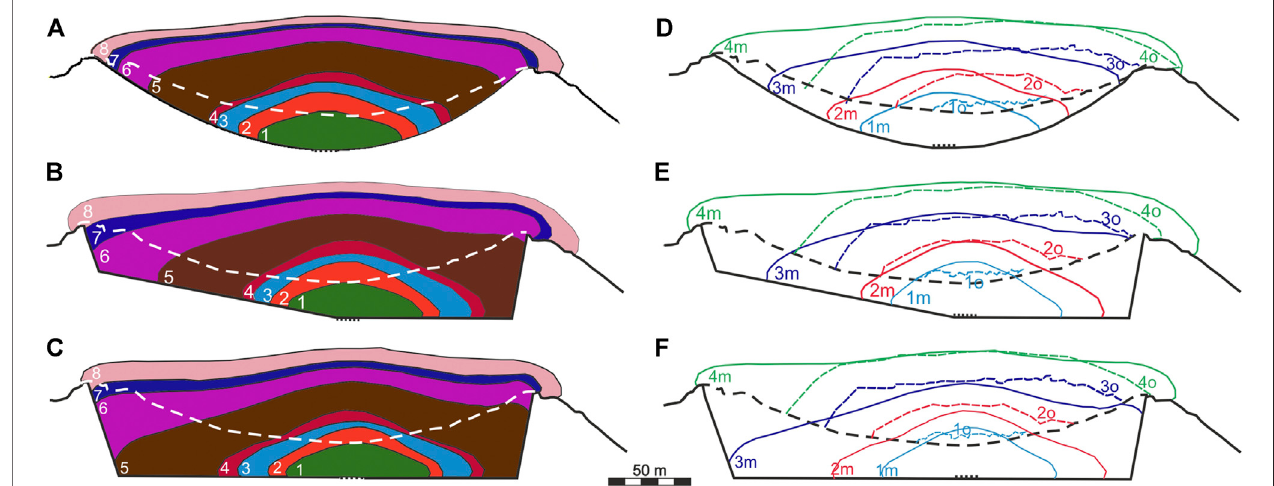
FIGURE6| Lavadomegrowth inexperiment4 (Aand D) ,5 (BandE) ,and6 (CandF) . (A – C) Thedomemorphologyatday150(the curvemarkedby1),300(2), 434 (3), 480 (4), 700 (5), 852 (6), 912 (7), and 1,020 (8). The white dashed line is the crater ’ s rim. (D – F) Comparison of the morphological shapes of the modeled (curves with index m) and observed (dashed curves with index o; see Figure 1E ) lava domes at day 300, November 1, 2007 (cyan curves); day 480, May 1, 2008 (red curves); day 704, December 4, 2008 (blue curves); and day 1,020, October 20, 2009 (green curves). The black dashed line is the crater ’ s rim. The black bold line presents the base of the crater, and the black dotted line is the top of the conduit.